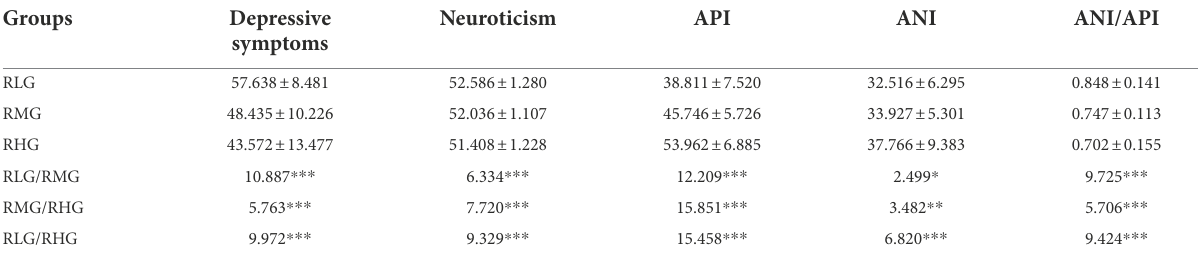
TABLE 2 Comparison of the Depressive symptoms, Neuroticism, API, ANI, and ANI/API scores of RHG, RMG, and RLG (Mean ± SD). Groups